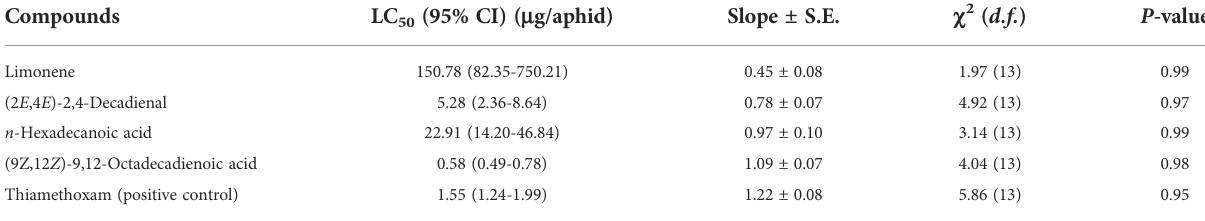
TABLE 4 The contact toxicity of primary compounds in PSO (pomelo seed oil) against Aphis. craccivora Koch after 24h treatment. Compounds LC 50 (95% CI) ( m g/aphid) Slope ± S.E. c 2 ( d.f. )